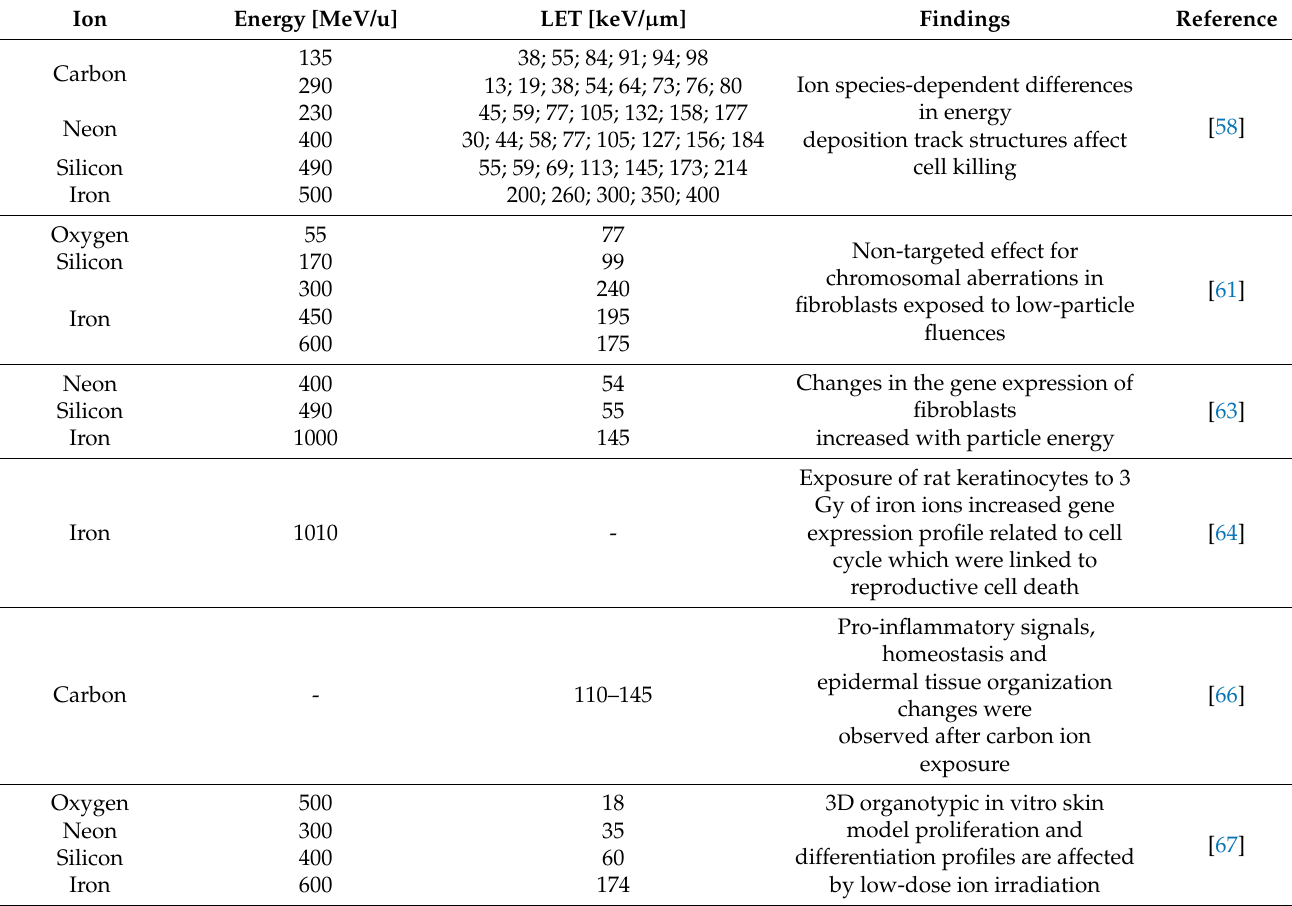
Table 2. Summary of ion exposure conditions of discussed studies